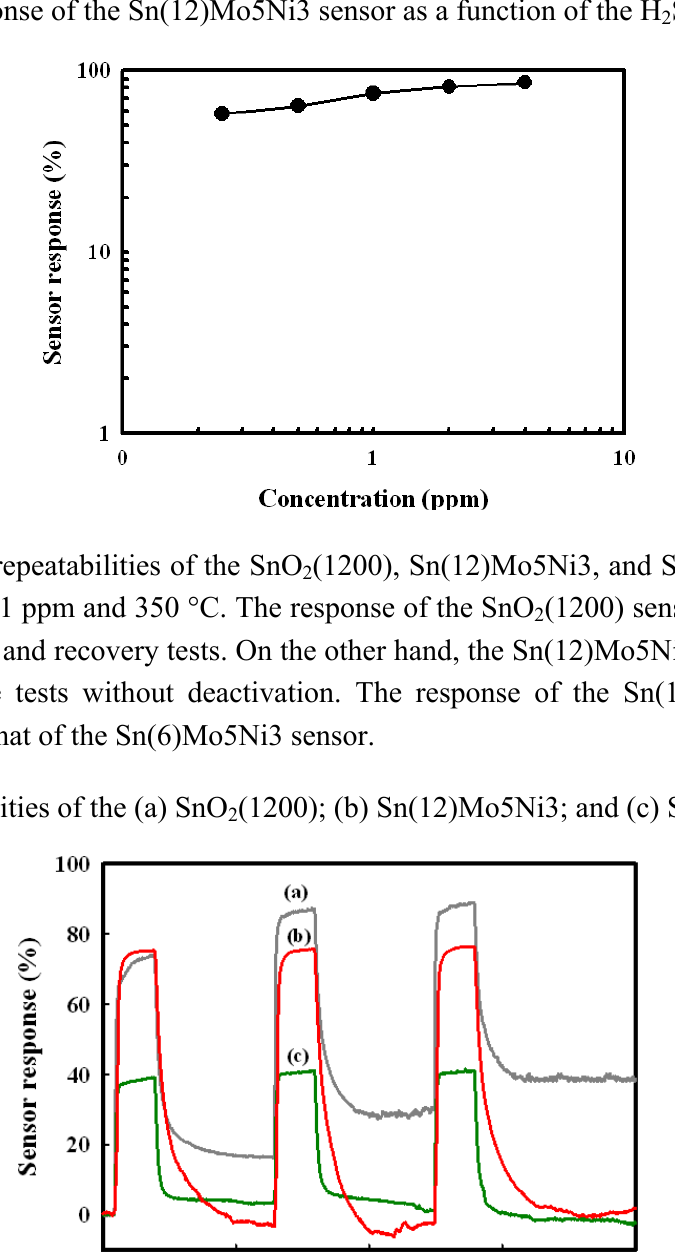
Figure 7. Response of the Sn(12)Mo5Ni3 sensor as a function of the H